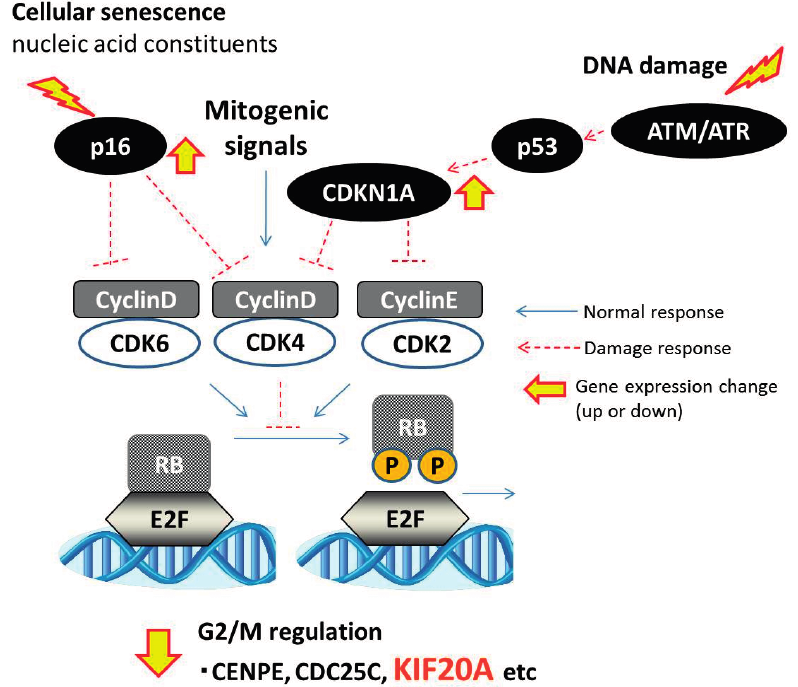
Figure 4. Proposed model of the roles of CDKN1A and KIF20A in cell cycle control via RB/E2F pathway. Mitogenic signals induce cell cycle progression, regulating cyclin D/ cyclin-dependent kinase (CDK) 4 or 6, and cyclin E/CDK2, and resulting in retinoblastoma (RB) phosphorylation. Phosphorylated RB releases E2F transcription factor, resulting in the induction of E2F transcriptional target genes including KIF20A . DNA damage induces upregulation of CDKN1A and downregulation of KIF20A via the RB/E2F pathway. Nucleic acid constituents induce downregulation of KIF20A by activation of p16 via RB/E2F; this pathway is termed cellular senescence